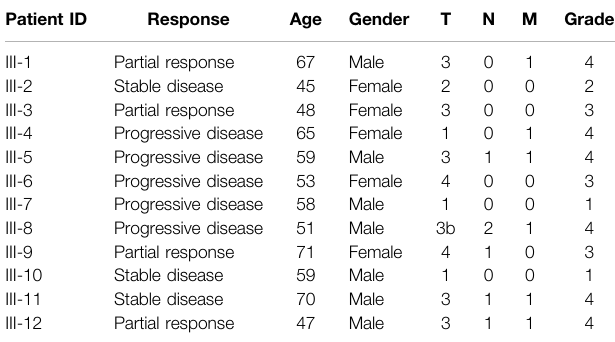
TABLE 3 | Outline of clinical information of patients whose samples were pro fi led using RT-PCR platform in this